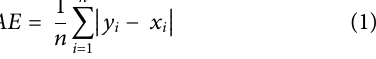
Frontiers in Earth Science |